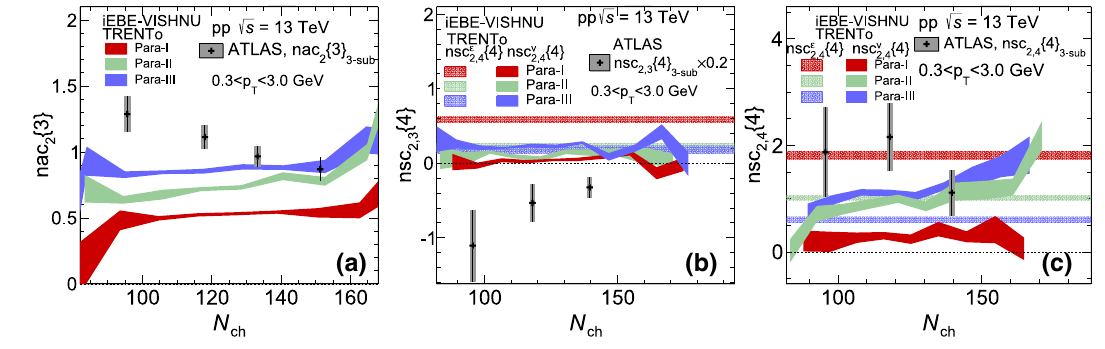
√ s = 13 TeV, calculated by iEBE-VISHNU with TRENTo initial { 4 } and nsc ε { 4 } of the initial state in 0–0.1% centrality bin are also shown. The ATLAS data 2 , 3 2 , 4